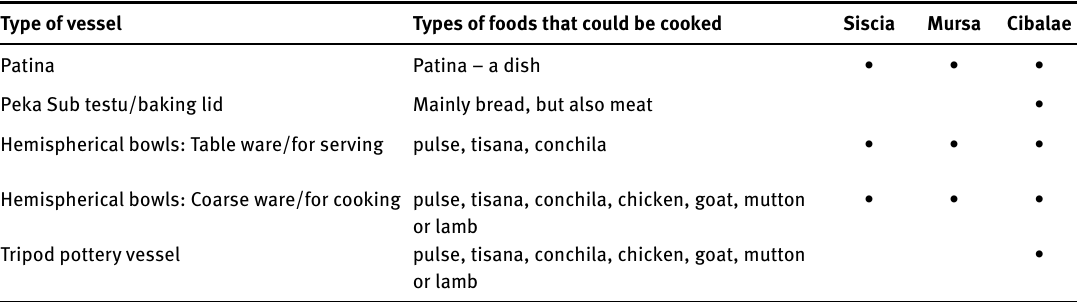
Table 4: Interpretation of foods that could be cooked in different vessels, based on Cato De agrigurlutra , Plinius Naturalis Historia , Apicius De re coquinaria and experimental